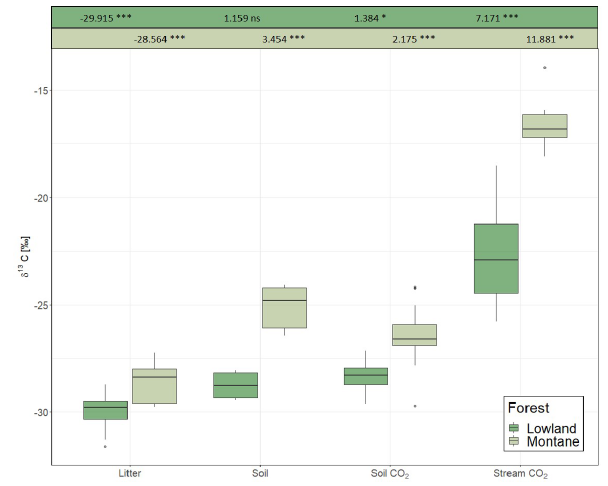
Figure 3. δ 13 C values of litter, soil organic carbon, soil-respired CO 2 , and dissolved CO 2 in headwater streams adjacent to the mon- itoring sites in the lowland and montane forests. Numbers on top are indicating the effect sizes of the two separate (lowland and mon- tane) linear mixed effect models. Numbers for litter are intercept, all subsequent numbers – soil, soil CO 2 , and stream CO 2 – are effect estimates relative to the